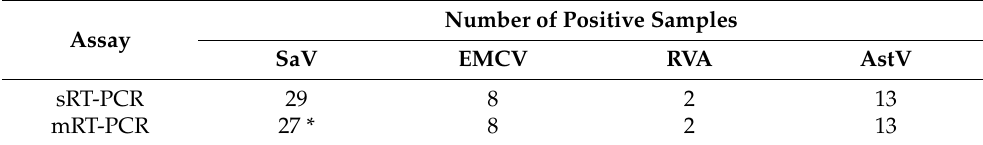
Table 3. Detection of four viruses in 130 field samples by sRT-PCR and mRT-PCR. Number of Positive Samples Assay SaV EMCV RVA AstV sRT-PCR mRT-PCR 27 *